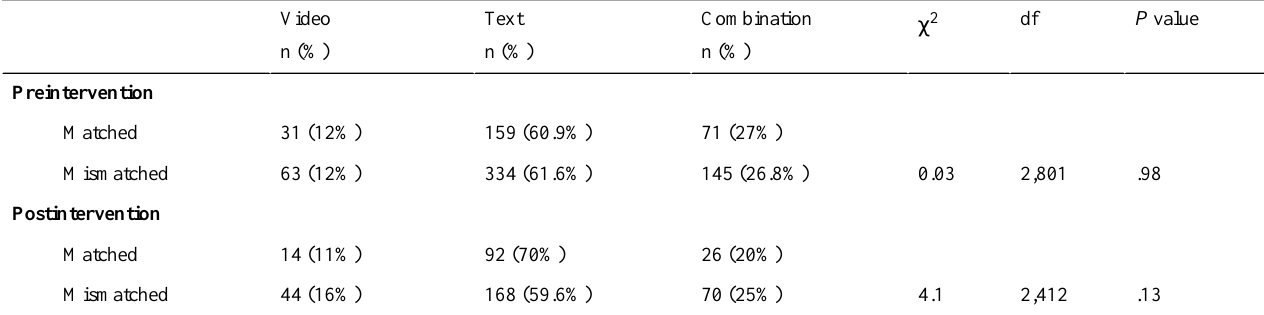
Table 2. Delivery mode preferences for matched and mismatched participants pre- and postintervention.